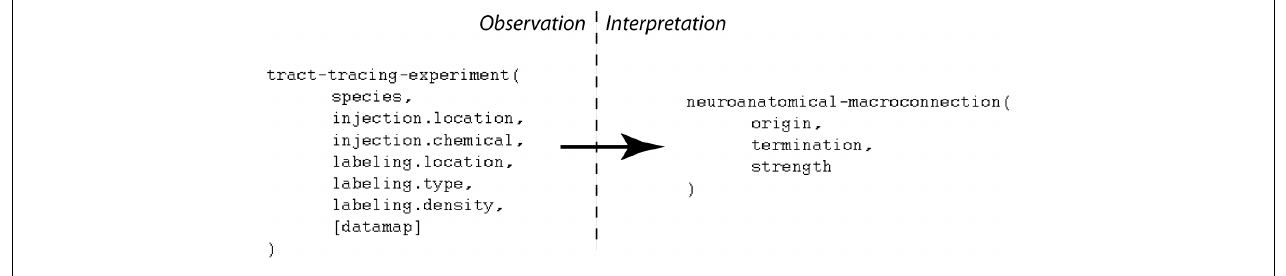
describing a macro connection. Note the presence of an additional variable (“data map”) assigned to the histological maps that may be viewed within the NeuARt